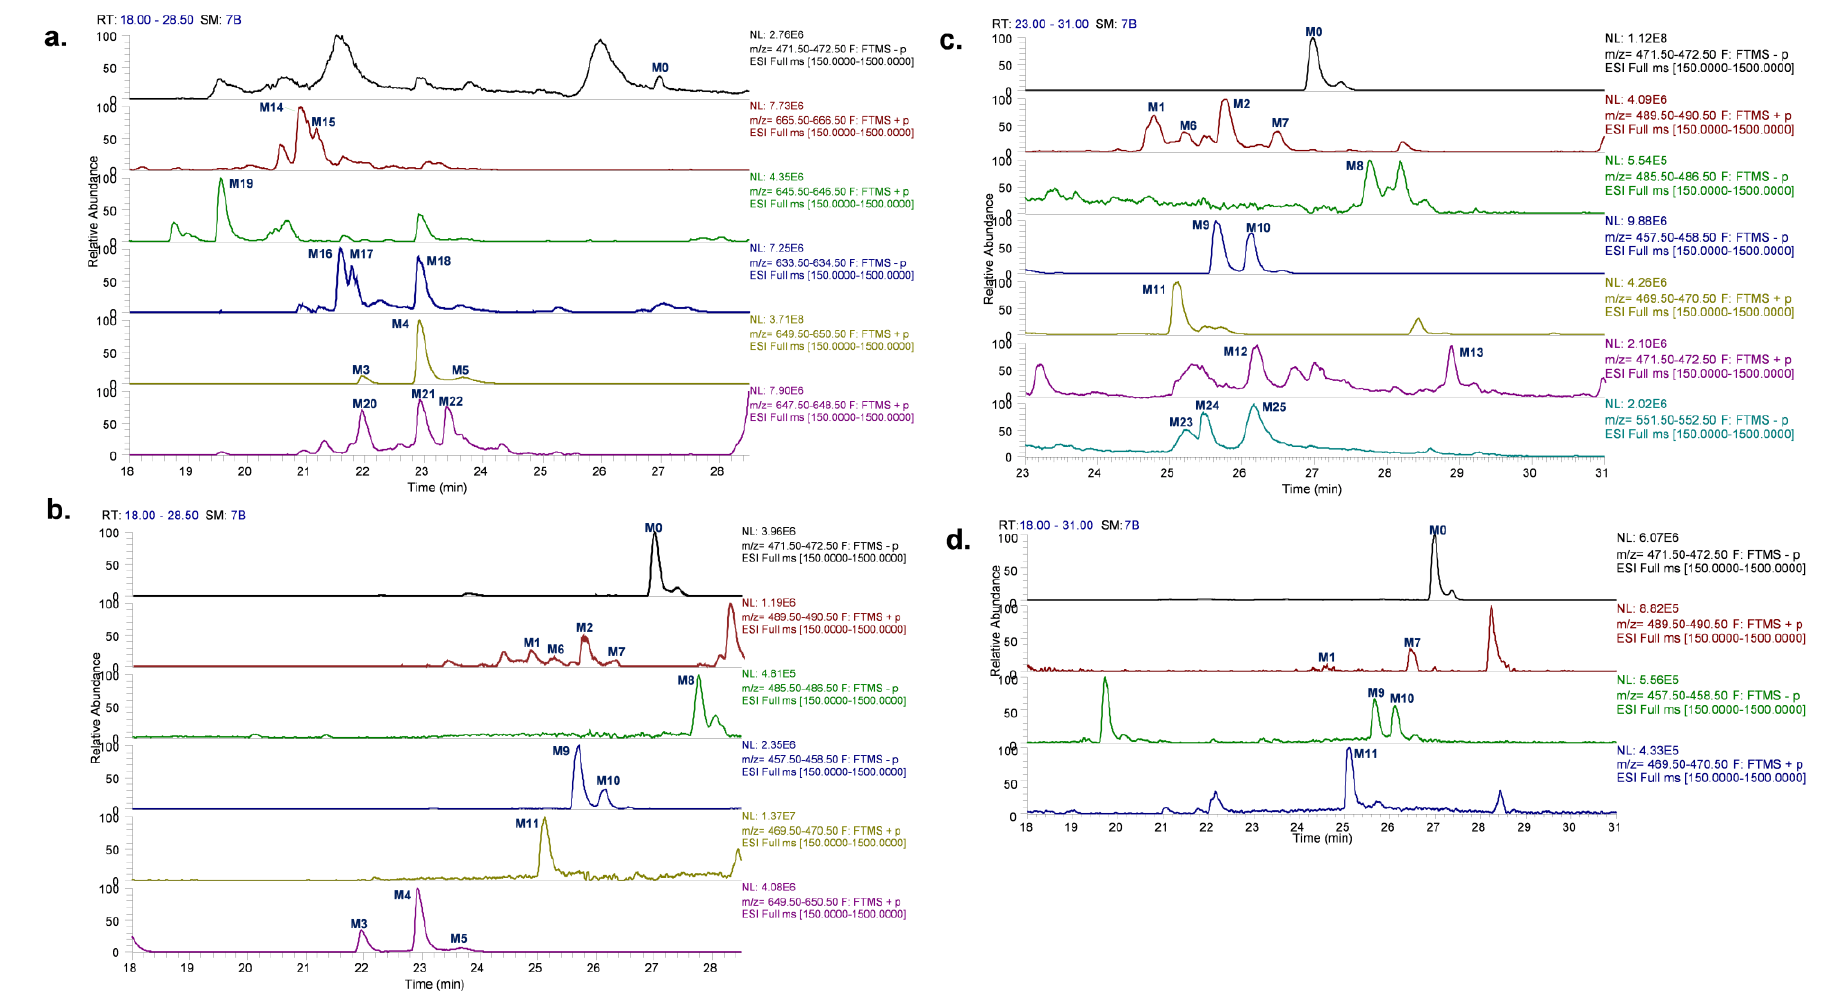
Figure 1. EIC of PND and its metabolites in rat bile ( a ), plasma ( b ), feces ( c ) and urine ( d ).